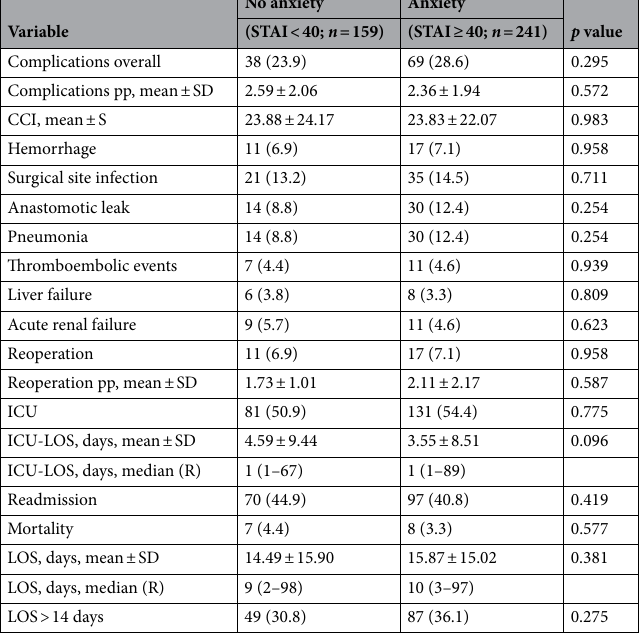
model. Supplemental Table 2. After adjusting for covariates, open surgery and HBP procedures remained significant predictors of morbid- ity, as shown in Table 4. The incidence of specific complications did not differ significantly between groups, nor did the need for intensive care unit (ICU), readmission rate, or length of hospital stay. Overall, 167 patients (70 patients [44.9%] in the no anxiety group and 97 patients [40.8%] in the anxiety group) were readmitted after discharge for any reason. The percentage of patients who were readmitted for complications related to the index procedure was not significantly different between the anxiety and no anxiety groups (12.5% vs. 15.1%, p = 0.584). Overall, 15 patients died after surgery, yielding an overall in-hospital mortality rate of 3.8%. Analysis of the mortality rate by group indicated that 3.3% of the patients (8 of 241) who were anxious died during hospitaliza- tion following surgery, compared with 4.4% of the patients (7 of 159) who were not anxious ( p = 0.577). Thus, the mortality rate of the anxiety group was similar to that of the no anxiety group. In multivariable analysis adjusted for covariates, preoperative patient-reported anxiety was not associated with mortality. The point estimates and CIs for the multivariate analysis are shown in Table 4. Subgroup analysis. Because the sample size of each prespecified general surgical procedure was small for meaningful statistical results, we reanalyzed a subgroup of patients ( N = 221, 55.3% of the study population) with the most complex surgical procedures mainly due to cancer (77.4%). This included those patients who underwent esophageal resection, including gastrectomy ( n = 51), colorectal resection ( n = 81) and hepatopancre-